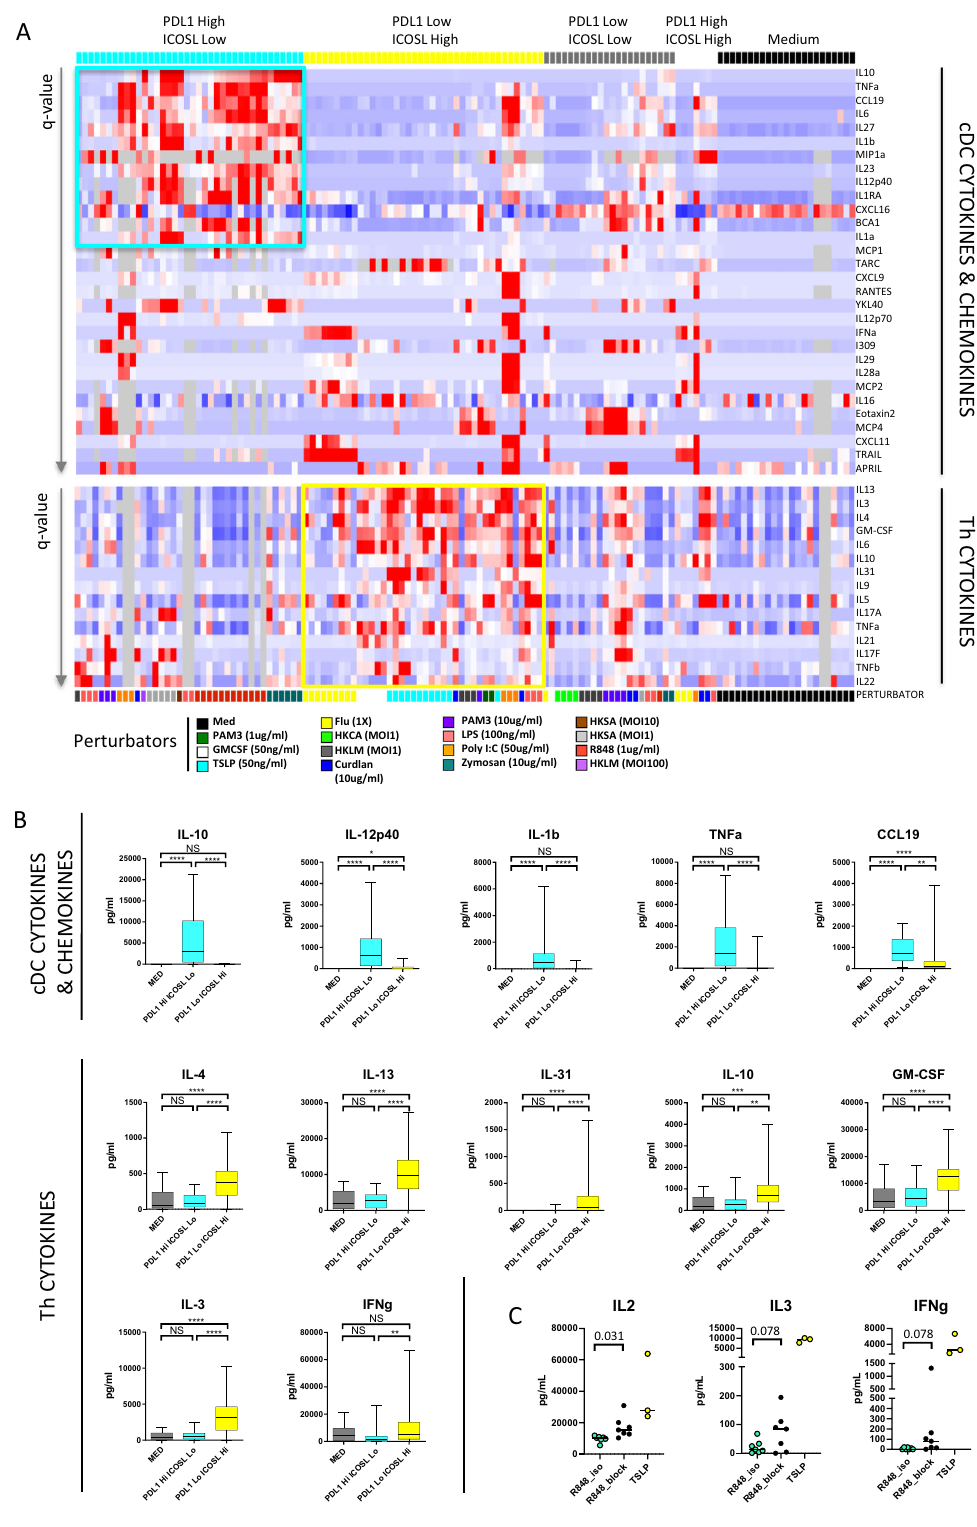
search large supervised lists of genes coding for checkpoints and maturation markers (148 genes, Supplementary Data 4), cyto- kines and chemokines (117 and 52 genes, respectively, Supple- mentary Data 5 – 6), and of the NFkB pathway, known for its importance in cDC activation 23 (100 genes, Supplementary Data 7), and identi fi ed in total 83 genes in common with